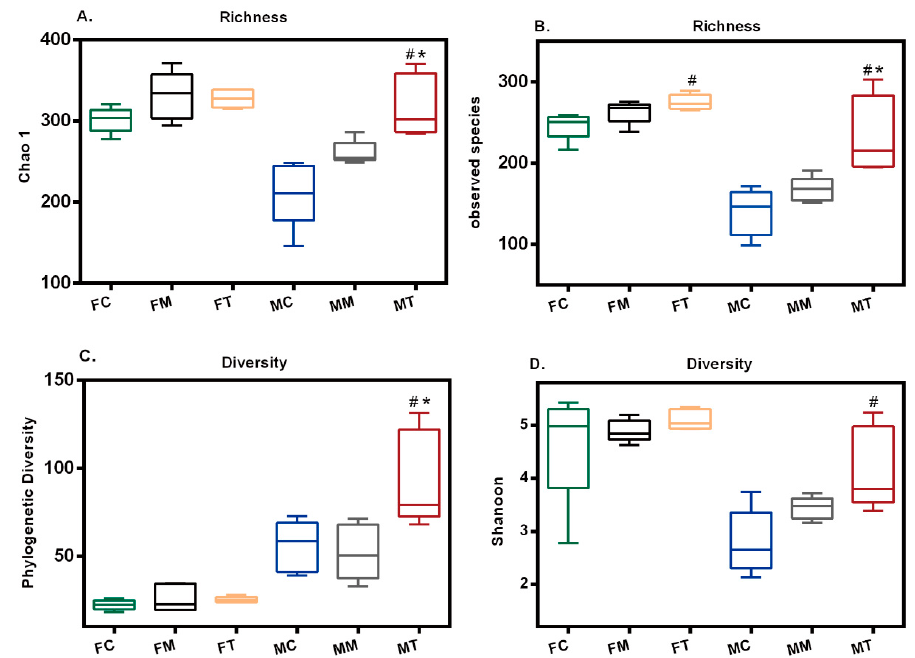
Figure 6. Tiansi Liquid treatment alters gut microbiota richness and diversity in fecal and intestinal samples. Chao 1 ( A ), observed_species ( B ), Phylogenetic Diversity ( C ), Shanoon ( D ). Box pots display the first (25%) and third (75%) quartiles, the median and the maximum and minimum observed values within each data set. There were five rats in each group. Statistical analyses were performed using one-way ANOVA and Tukey—Kramer post hoc comparisons. FC, FM and FT denote the control, model and Tiansi-treated groups of the fecal samples, respectively; and MC, MM and MT denote the control, model and Tiansi-treated groups of intestinal mucosa samples, respectively. # p < 0.05, vs. control group; * p < 0.05, vs. model group.